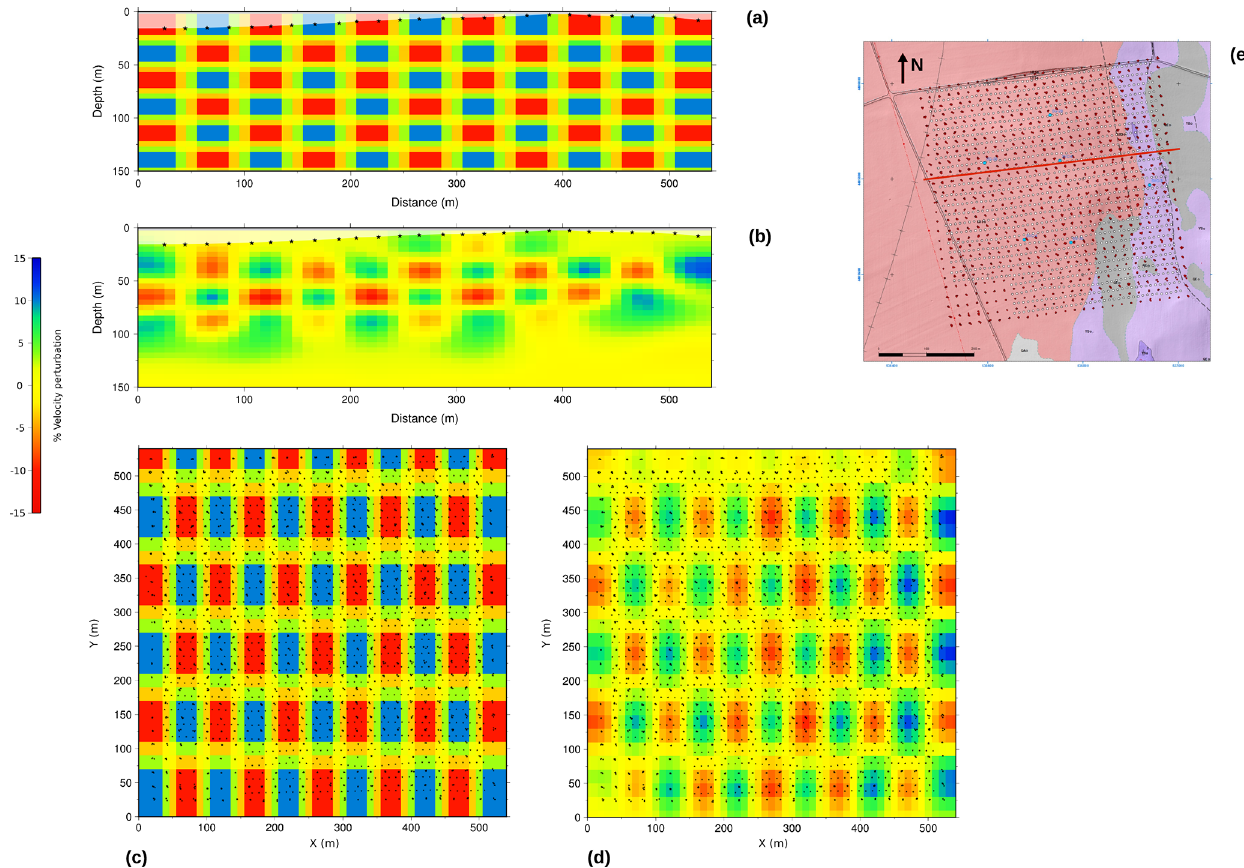
Figure 5. Checkerboard tests taking into account the real acquisition geometry on a model involving velocity anomalies of dimensions 50m × 75m × 25m and 10% velocity perturbation. (a) Cross section of the input synthetic velocity model consisting of box anomalies. (b) Cross section across the recovered velocity model. The shot points (black dots) define the topography, with respect to the reference level of the inverted model, below which velocity recovery takes place. (c) Depth slice (map view) across the input model showing the synthetic velocity anomalies. (d) Depth slice across the recovered velocity model at a 45–50m depth with respect to the reference level of the inverted model. (e) Acquisition geometry showing the location of the vertical sections of (a) and (b)